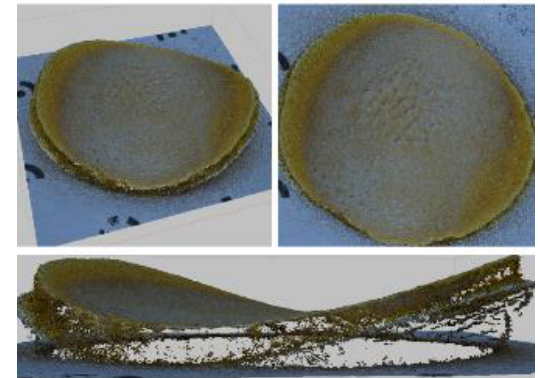
Figure 6. Data processing